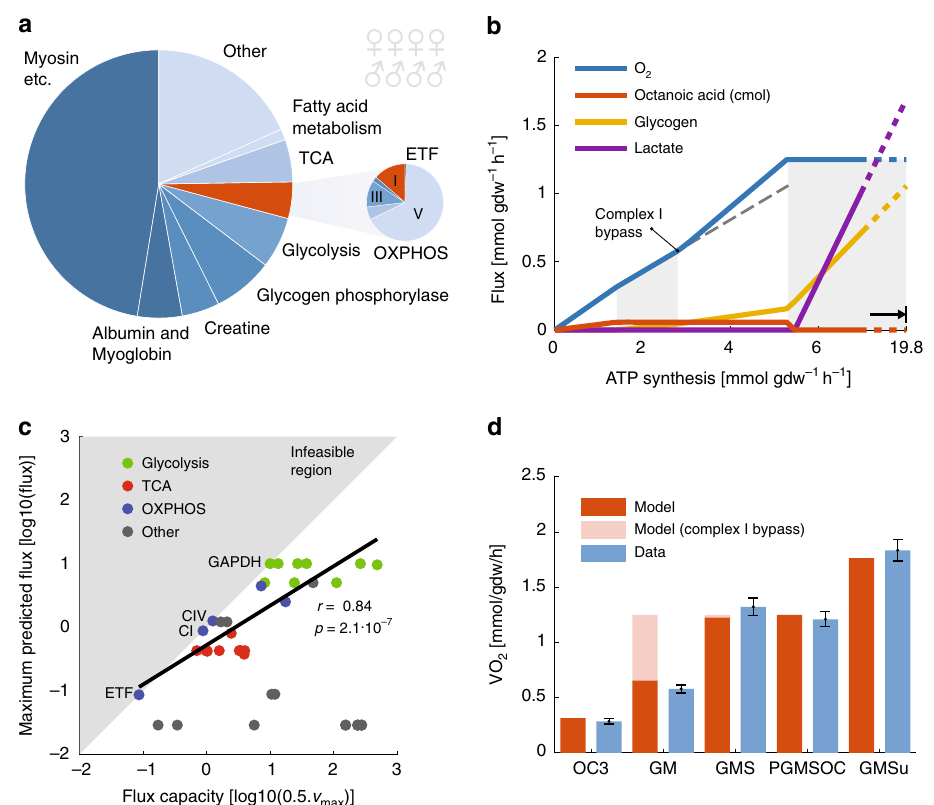
Fig. 2 Metabolic modes in muscle fi bers. a Most of the mass of muscle fi bers, calculated from a published proteomics data set 28 , is allocated to motor proteins and metabolic enzymes. b The predicted fl uxes at increasing ATP synthesis rates show four linear modes (white and gray shading). Extrapolated oxygen fl ux (dashed gray line) highlights that the slope of O 2 increases after complex I bypass. All fl uxes were calculated using enzyme concentrations as constraints and minimizing the substrate utilization (maximizing ATP per cmol). c The maximum predicted fl uxes cannot exceed the fl ux capacity constraints (indicated by the shaded gray area). The predicted ATP synthesis is thus constrained by four enzymes in order, electron transfer fl avoprotein dehydrogenase (ETF), complex I (CI), complex IV (CIV), and glyceraldehyde 3-phosphate dehydrogenase (GAPDH). There is a strong Pearson ’ s correlation between fl ux capacity and predicted fl uxes for the enzymes from glycolysis, citric acid cycle (TCA), and oxidative phosphorylation (OXPHOS). d The maximum predicted oxygen fl ux under different conditions was in good agreement with literature data under the corresponding conditions from muscle fi bers 33 . The conditions were octanoic acid, an ETF substrate (OC); glutamate, a complex I substrate (GM); glutamate + succinate, a complex II substrate (GMS); glutamate + succinate + octanoic acid (PGMSOC3); glutamate + succinate in presence of a mitochondrial uncoupler (GMSu), this was simulated by removing constraints from the proton gradient-dependent OXPHOS enzymes. Each simulation was run with and without complex I bypass (blocked fl ux through gly-phos). The literature data were recalculated from wet to dry weight by an assumed water content of 80%, error bars show